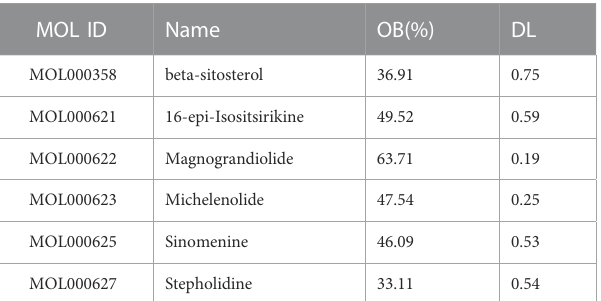
TABLE 1 The active ingredients of